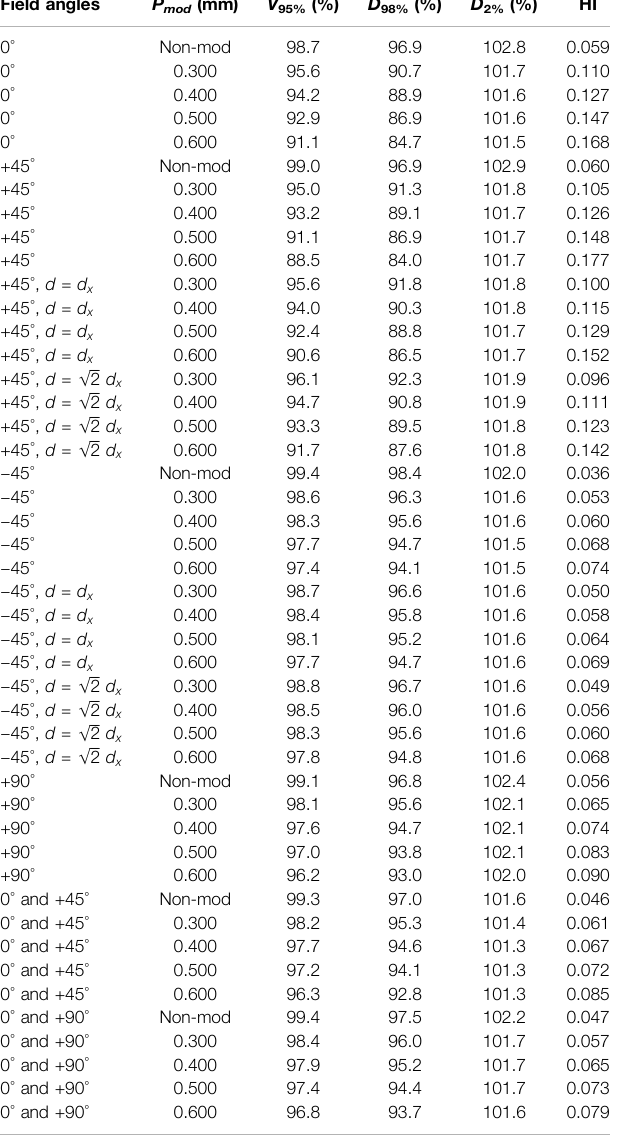
TABLE 2 | Dosimetric indices for carbon ion treatment plans for P1 with ρ range of 0.1 – 0.5 g/cm 3 and different planning parameters. Field angles